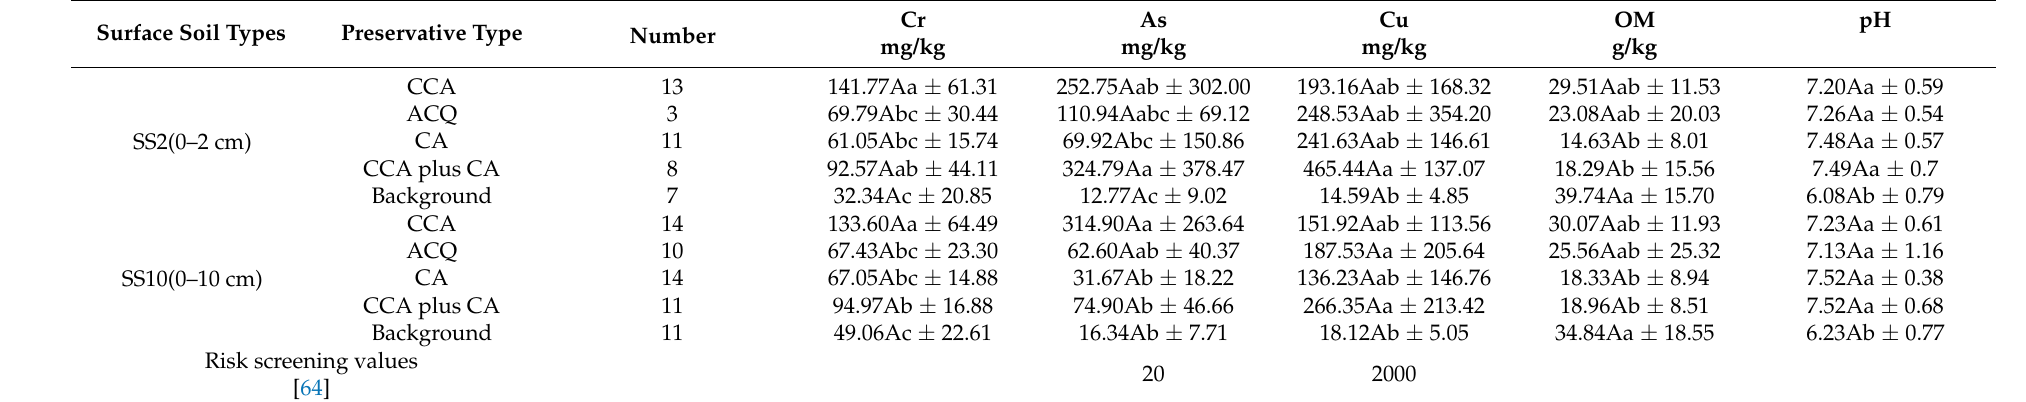
Table 3. Metal(loid)s concentrations in surface soils under boardwalks in the JNNR, Southwest